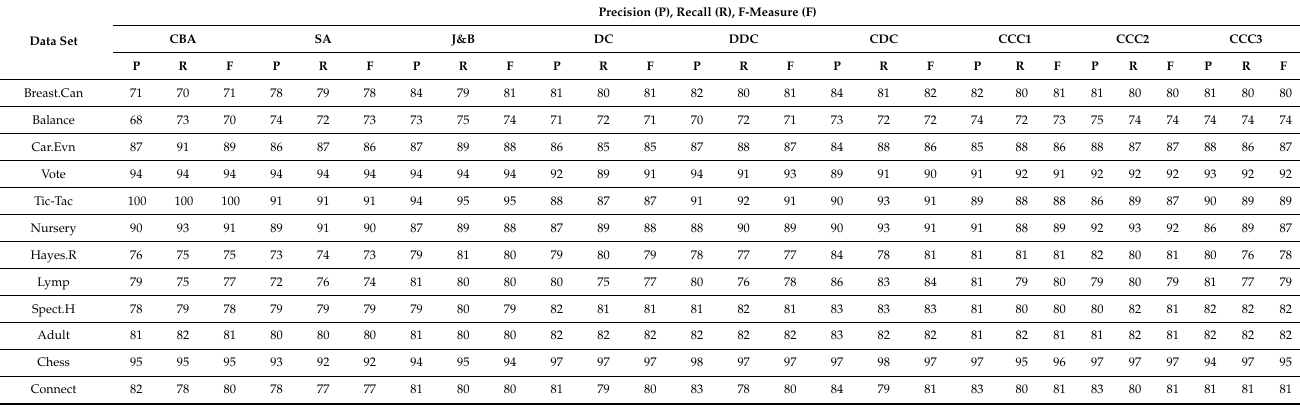
Table A1. Weighted relevance measures